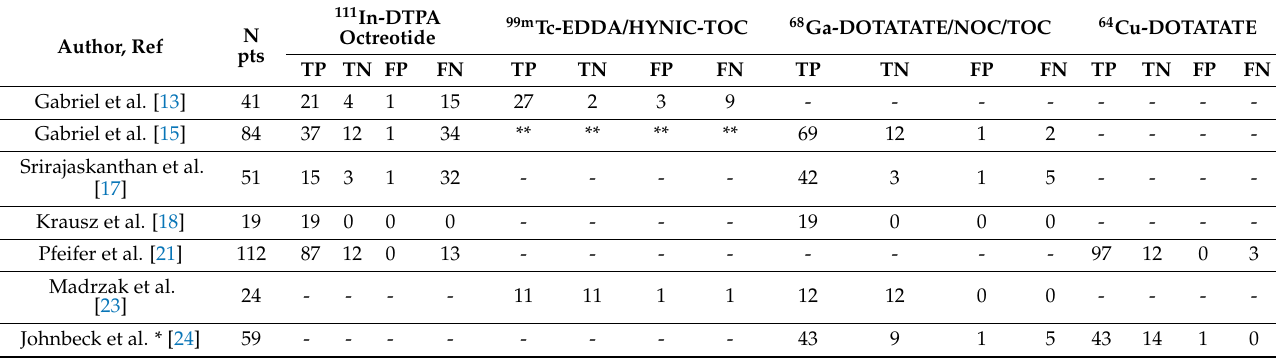
Table 2. Patient-based performances of the diverse radiopharmaceutical